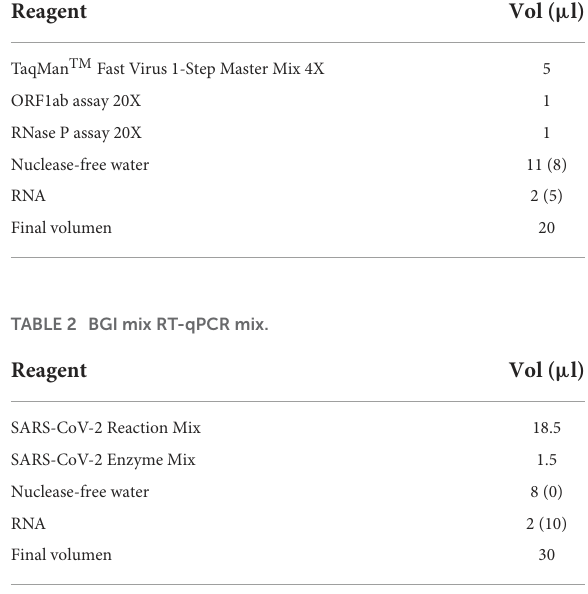
TABLE 3 Roche RT-qPCR mix.